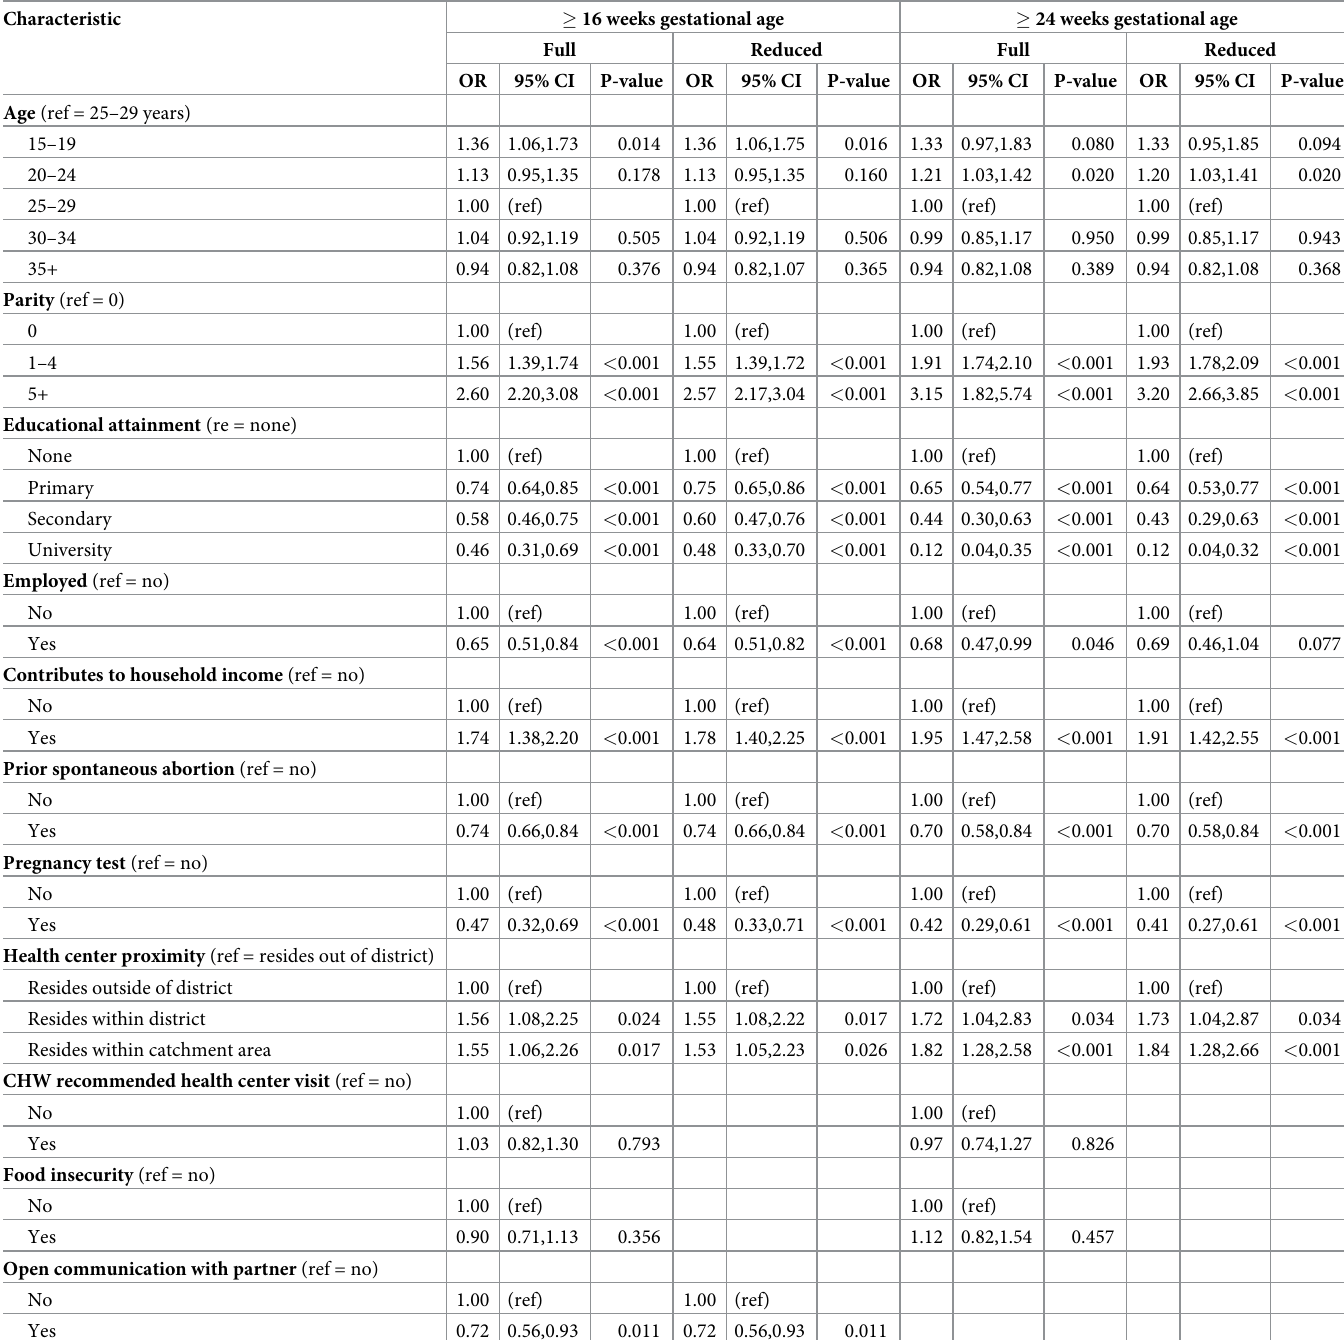
Table 3. Multivariable predictors of late and very late presentation to antenatal